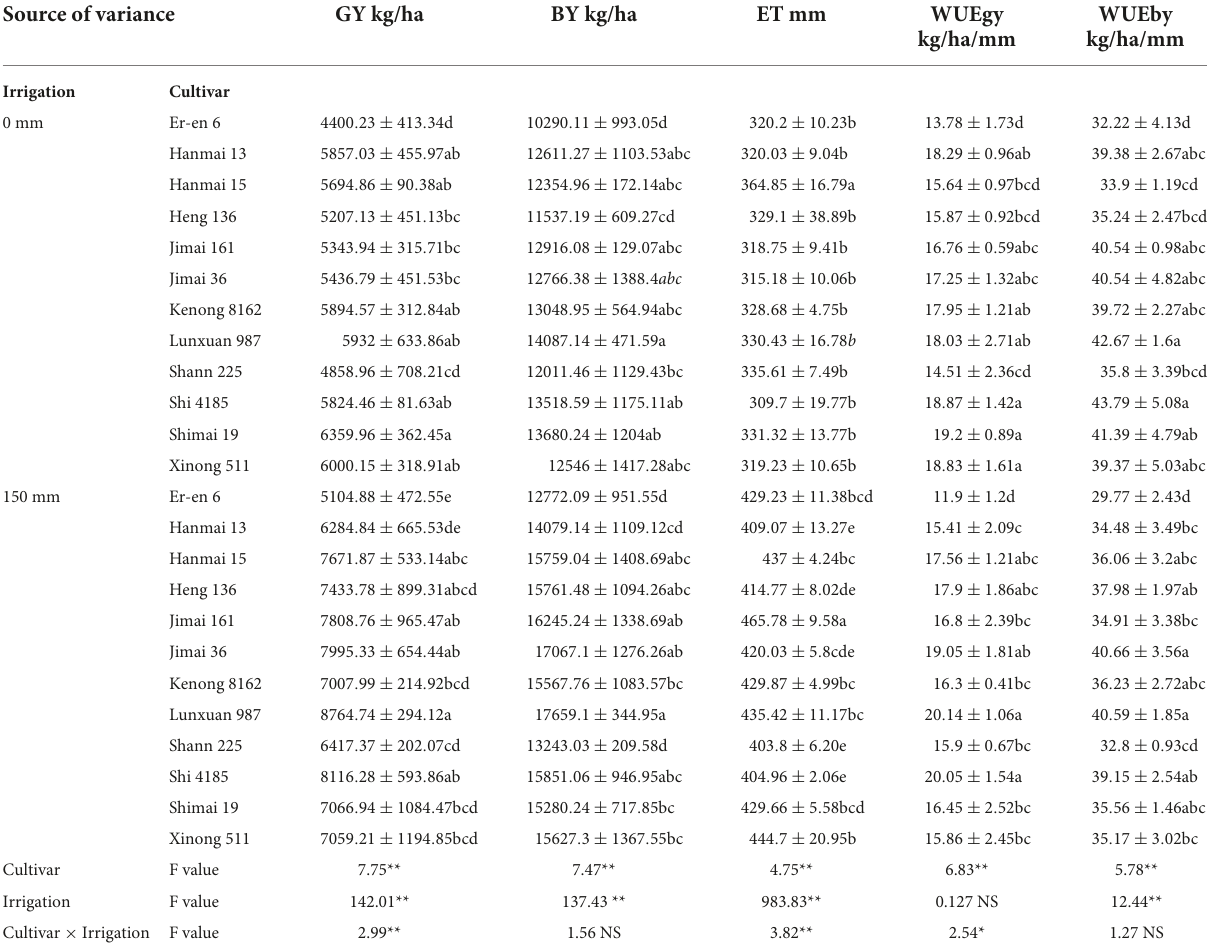
TABLE 3 Effects of cultivar and irrigation on field observed grain yield (GY), Biomass yield (BY), evapotranspiration (ET), and water use efficiency at grain yield level (WUE gy ) and biomass yield level (WUE by ). Source of